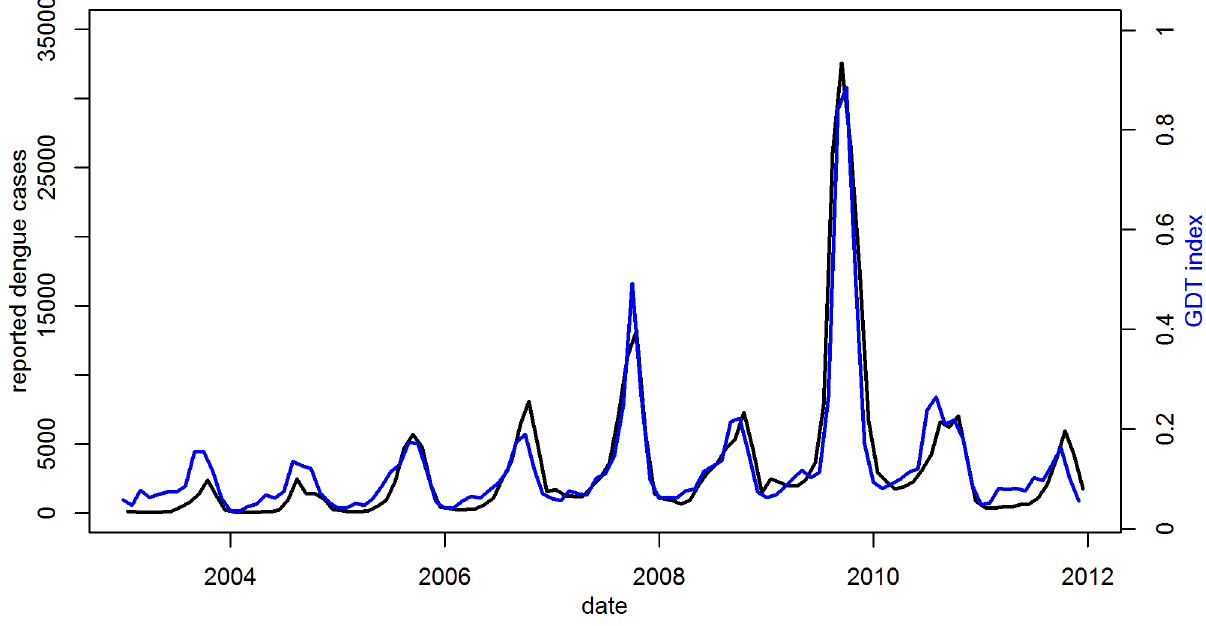
Figure 1. Time Series of monthly reported cases and Google Dengue Trends, Mexico. 2003–2011. The number of cases reported by the Secretariat of Health is shown on the left axis (black) and the GDT index on the right (blue). The correlation coefficient between reported dengue cases and GDT was 0.91 over the 9 years, indicating that GDT captured approximately 83% of the variability in the national surveillance data.